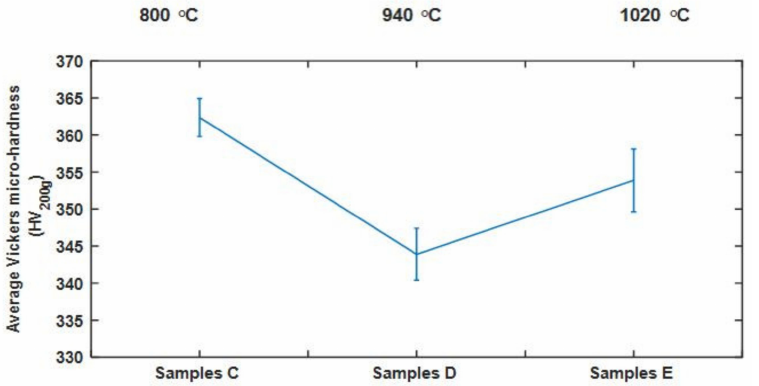
Figure 5. The average Vickers micro-hardness of various forms of DMLS Ti6Al4V(ELI) and their variation with heat treatment